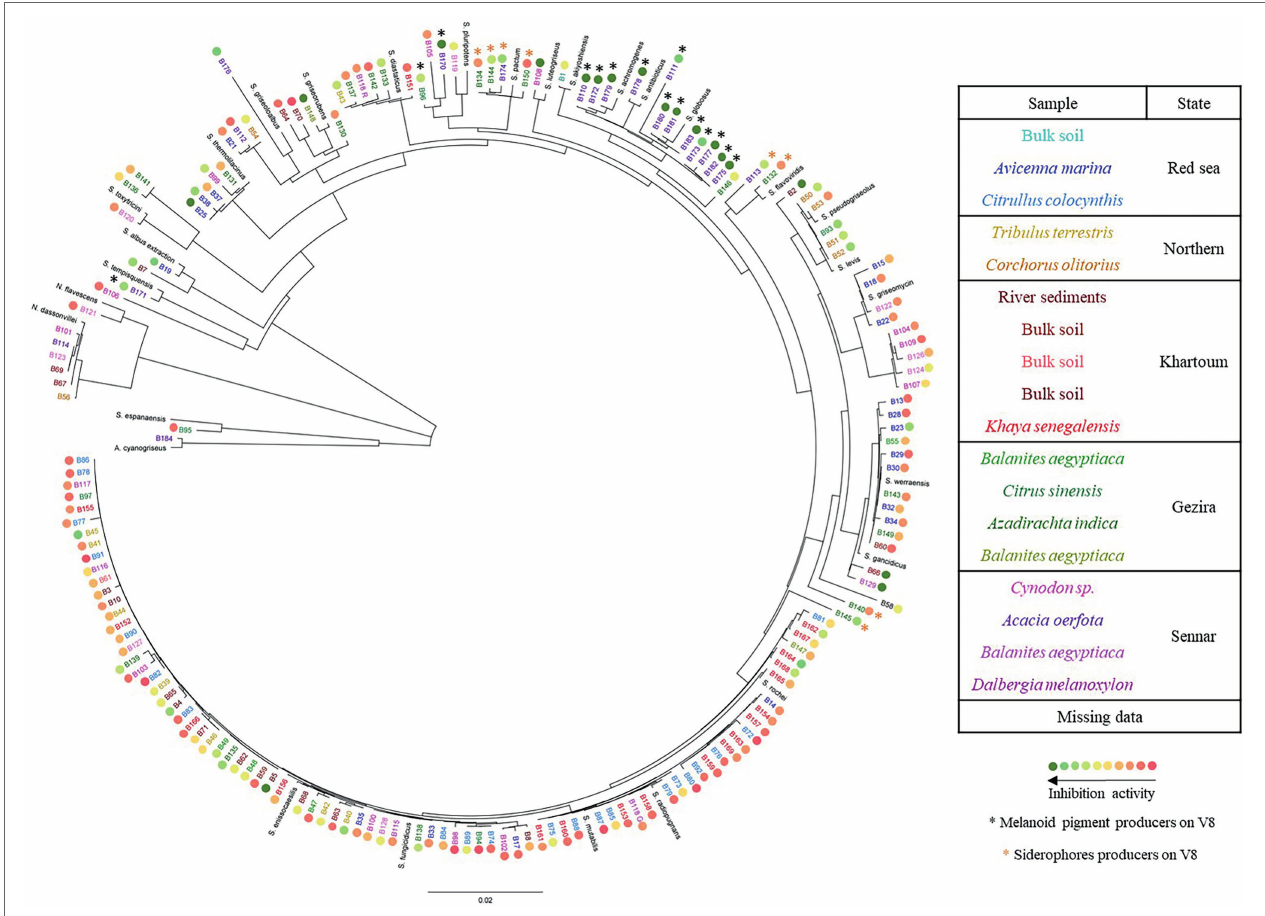
FIGURE 1 | Phylogenetic tree of the isolated Actinomycetes. The tree was constructed using the Geneious software and based on ca. 1,150 bp of the 16S rDNA gene sequence. Isolates from the same soil sample are shown in the same color. The colored circles ranging from green to red indicate the strains’ inhibition activity against the mycelial growth of Phytophthora infestans , the black asterisks indicate the strains which produce melanoid pigments when growing on V8 (see next section) and the orange asterisks indicate the strains which produce siderophores. Reference sequences from different species within Actinoalloteichus , Saccharothrix , Nocardiopsis ( N .), and Streptomyces ( S .) genera corresponding to the following accession numbers were included: Actinoalloteichus cyanogriseus (HG917901.1), Saccharothrix espanaensis (AB248288.1), Nocardiopsis dassonvillei (MN108027.2), N. flavescens (KU973976.1), S. achromogenes